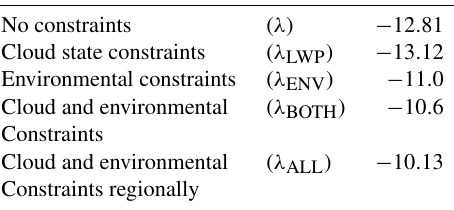
Table 1. Warm cloud shortwave radiative sensitivity to aerosol esti- mates with varying degrees of constraints in Wm − 2 ln(AI) − 1